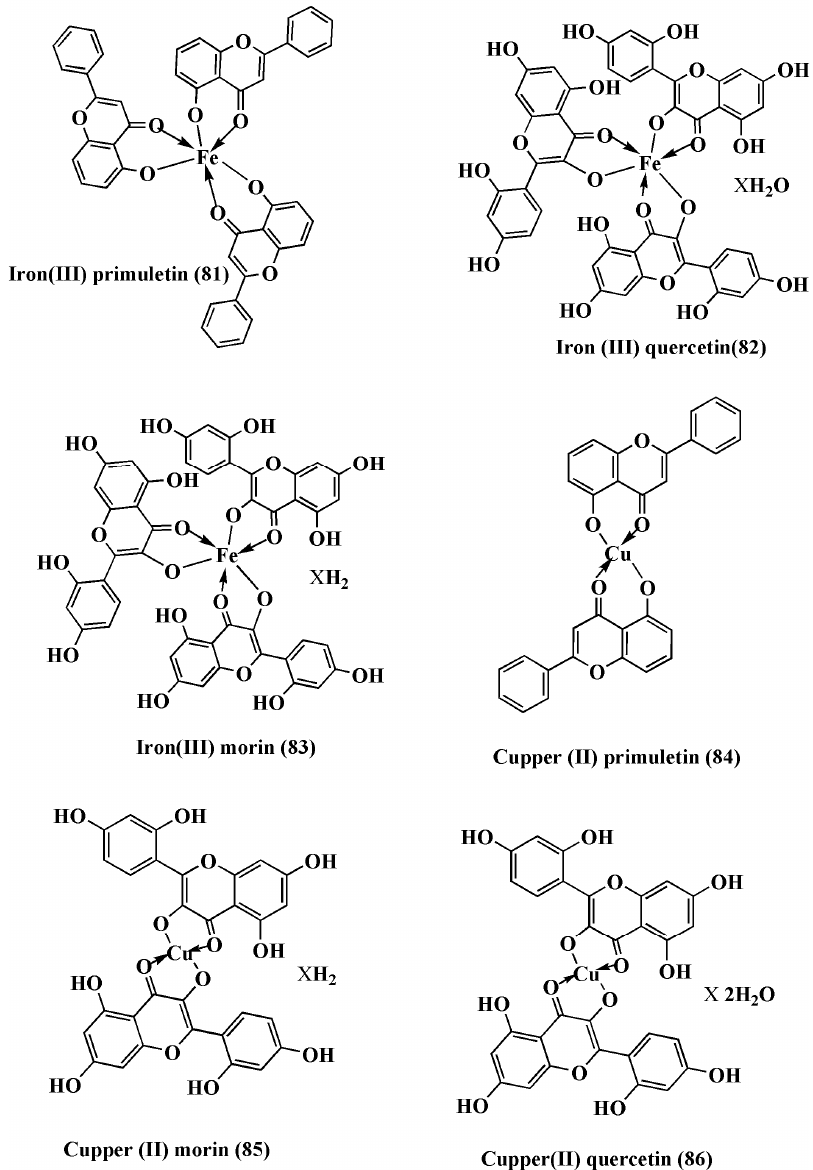
Figure 10. Structures of Fe(III) and Cu(II) complexes (81–86) with primuletin, quercetin and morin [153]. Table 6. Ki as well as IC50 values of the organic ligand & its metal chelates